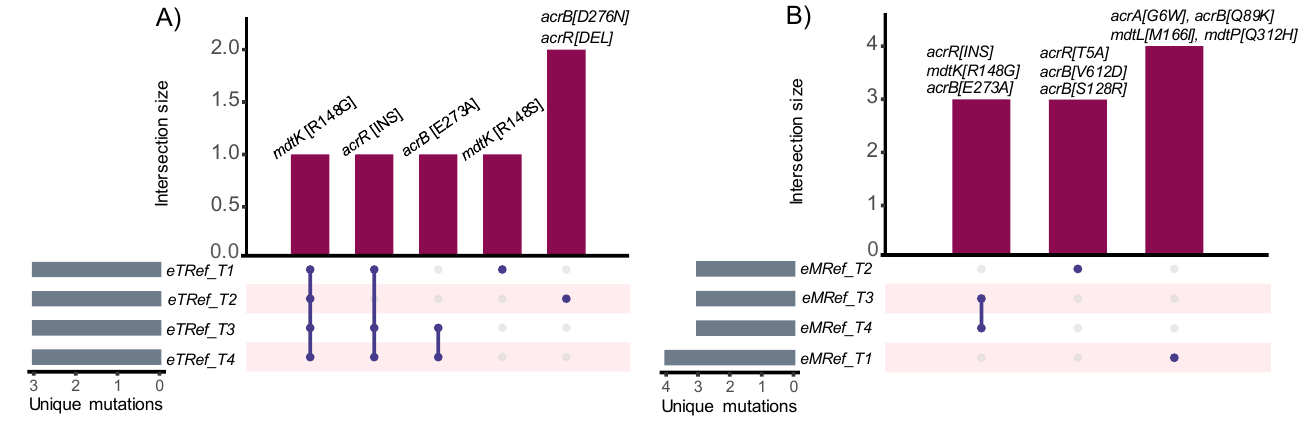
Figure 8. Overview of mutations associated with MDTs and their regulation in the evolved strains eTRef and eMRef . The UpSetR [110] plot depicts the possible convergence of mutations among all endpoint clonal isolates derived from ( A ) eTRef and ( B ) eMRef lineages. The mdtK (R148G) mutation occurred most frequently and was shared among independent parallel replicates in association with different mutations. The four parallel lineages are abbreviated to T1, T2, T3, and T4. Mutations from both clonal isolates were combined as one set and replicates were represented only once.